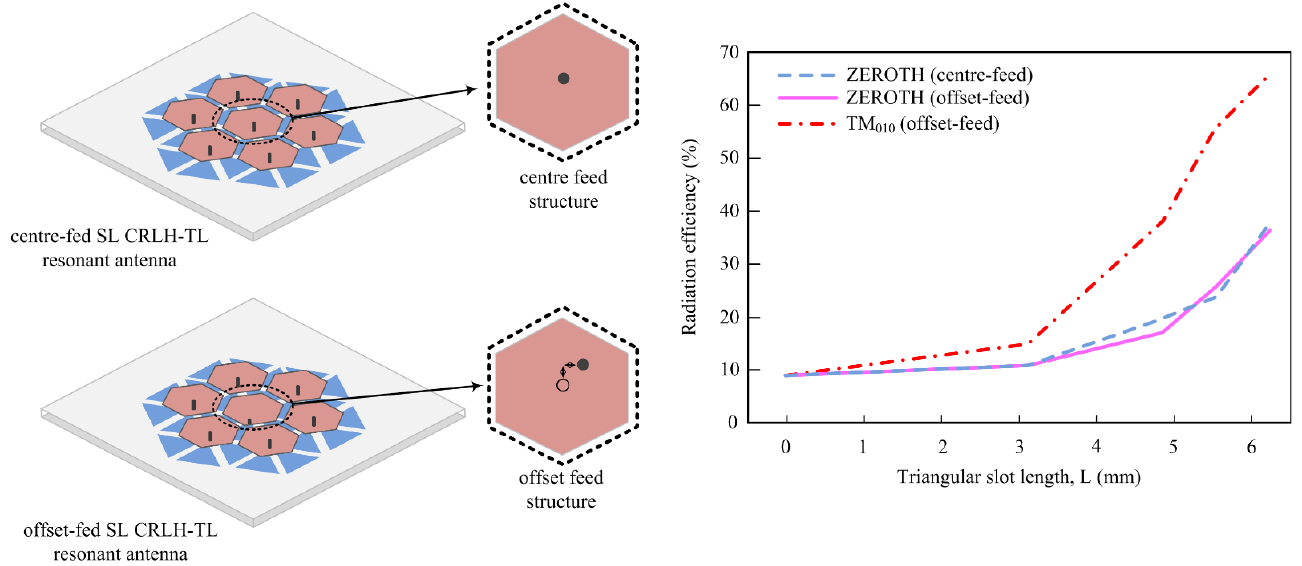
Figure 7. Efficiency enhancement mechanism of metamaterial-loaded antenna (adapted from [69]).